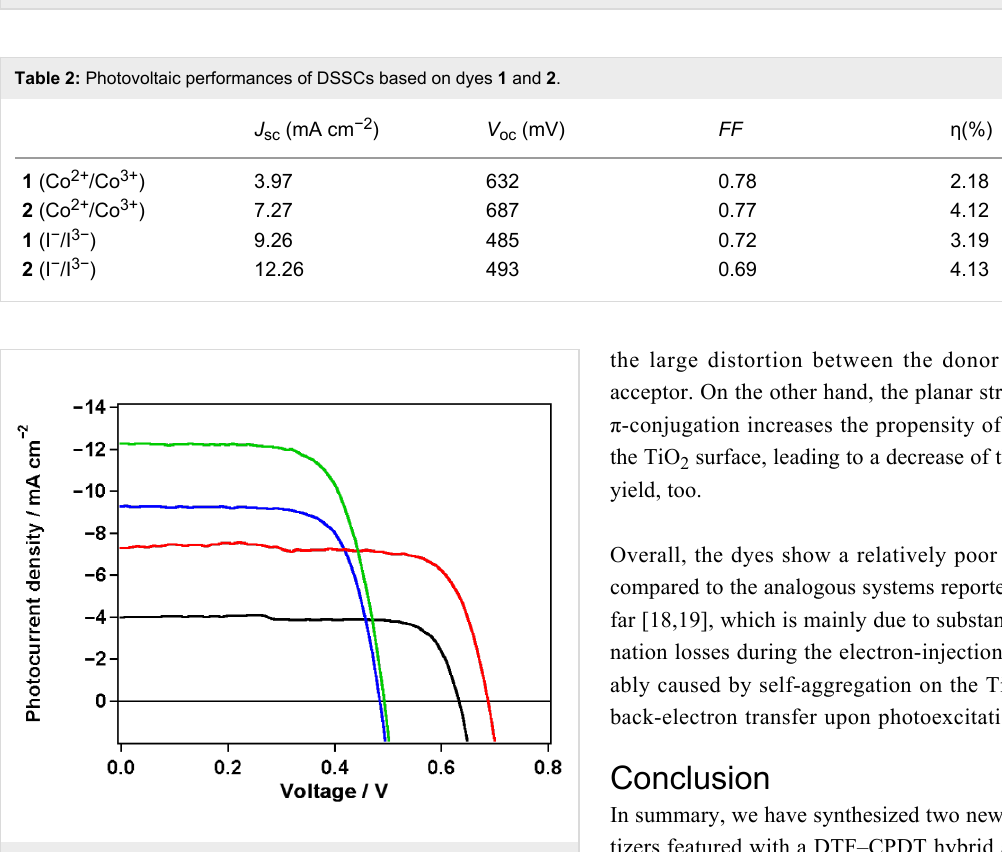
Figure 4: Photovoltaic performance of the two sensitizers. Photocur- rent density ( J ) as a function of voltage (V) for 1 (black and blue curves) and 2 (red and green curves) measured under standard air mass 1.5 and simulated sunlight at 1000 W/m 2